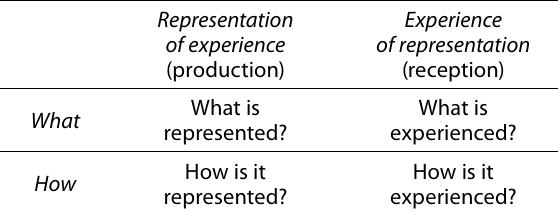
Table 1. The components of experiential